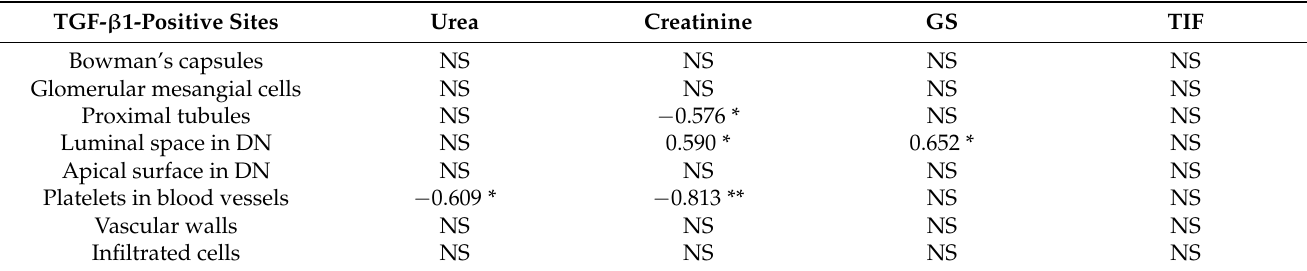
Table 1. Correlations between the expression of the transforming growth factor (TGF)-beta 1 and tissue damage in the kidneys of felines with chronic kidney